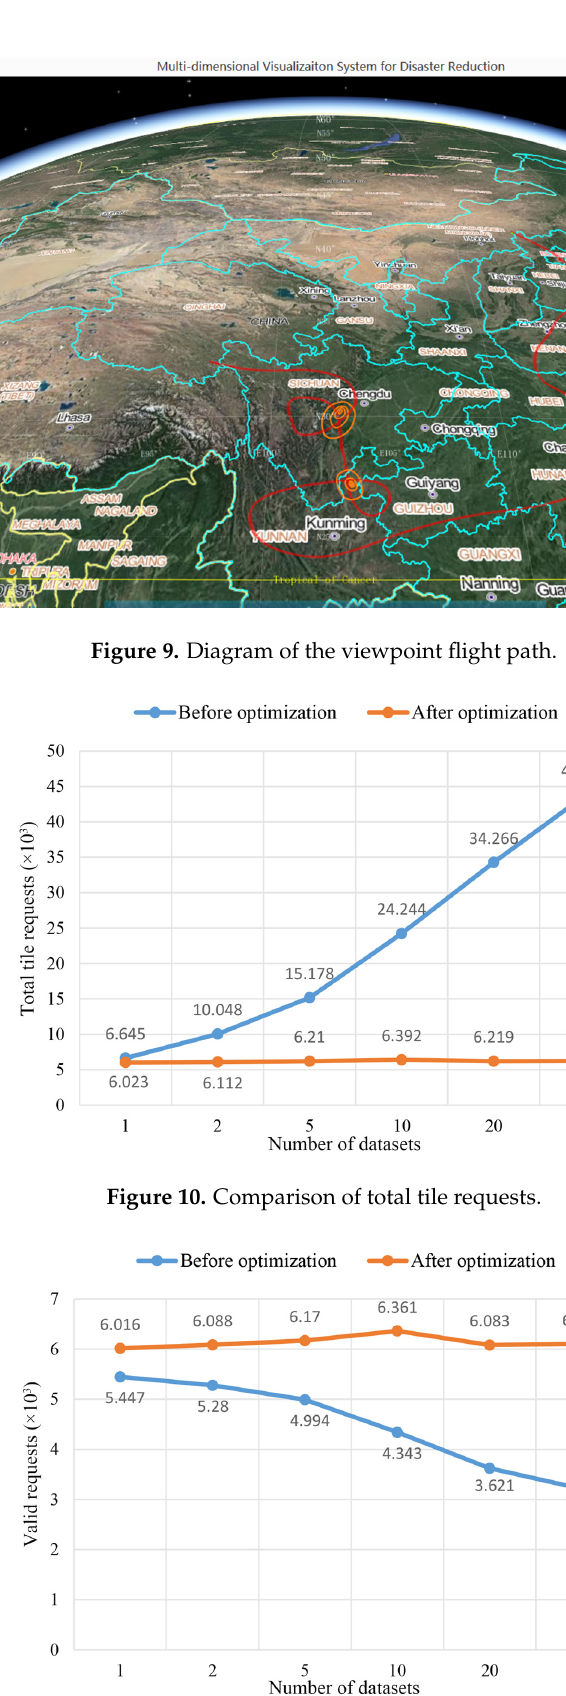
Figure 11. Comparison of valid tile requests.